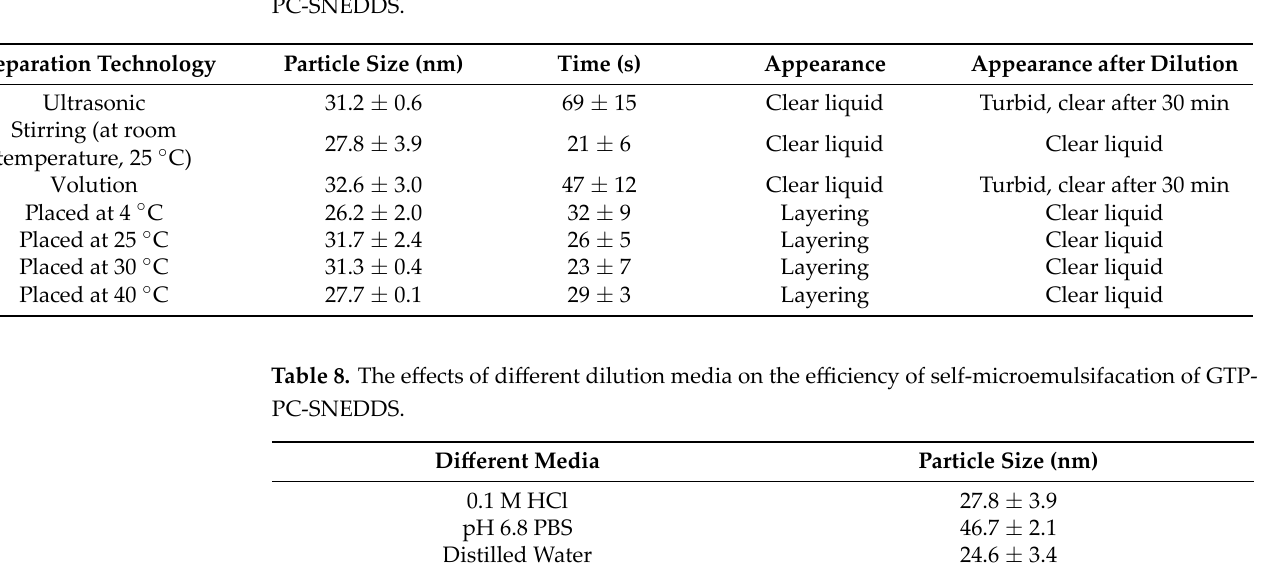
Table 7. The effect of preparation technology on the efficiency of self‑microemulsifacation of GTP‑ PC‑SNEDDS.